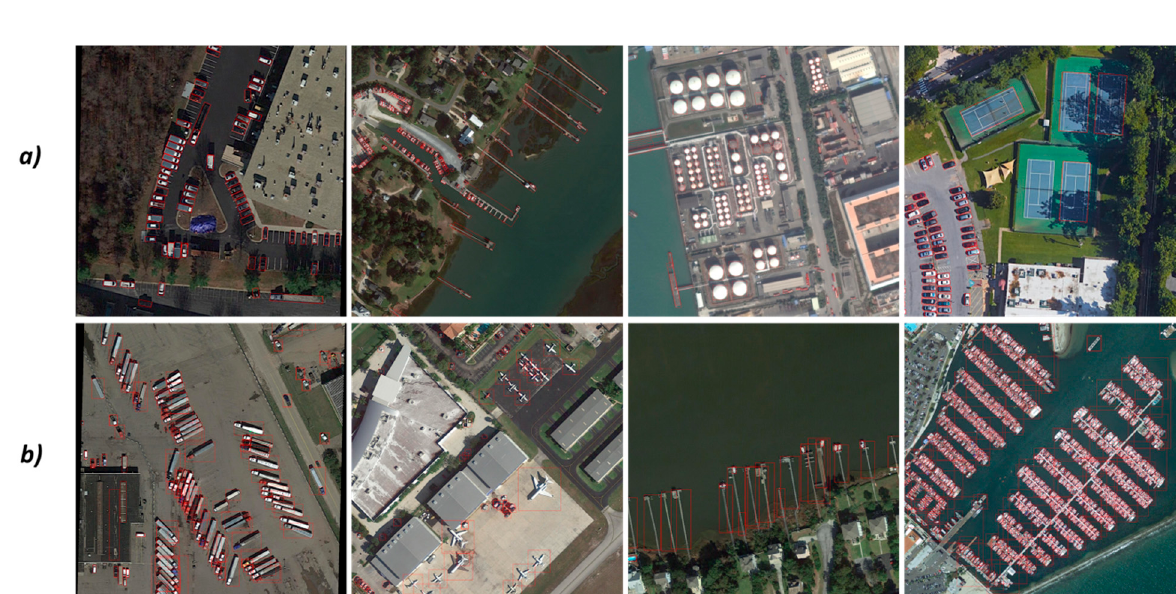
Figure 9. Examples of our detection results for both the OBB and the HBB tasks on the DOTA test set. ( a ): OBB task and ( b ): HBB task.